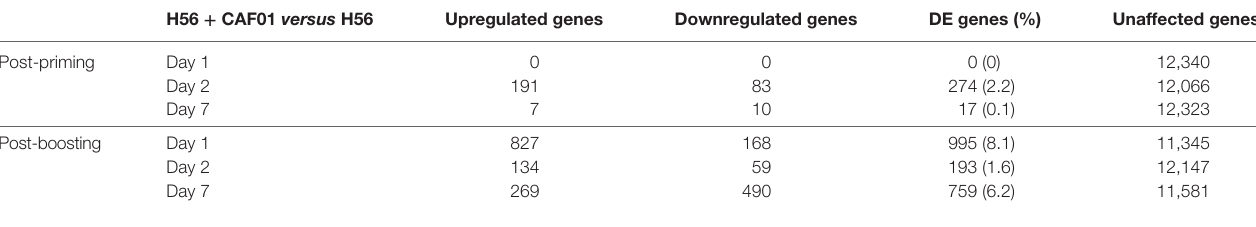
TaBle 1 | Number of differentially expressed genes in CAF01 adjuvanted mice. h56 + caF01 versus